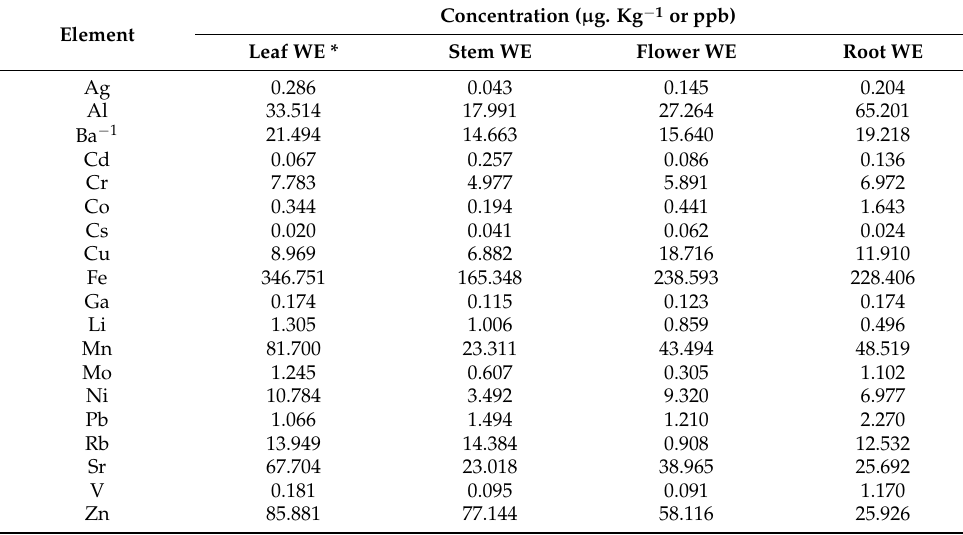
Table 1. Concentration of various elements from aqueous extract of different parts of Micromeria fruticosa plant using ICP-MS spectrometer. Element